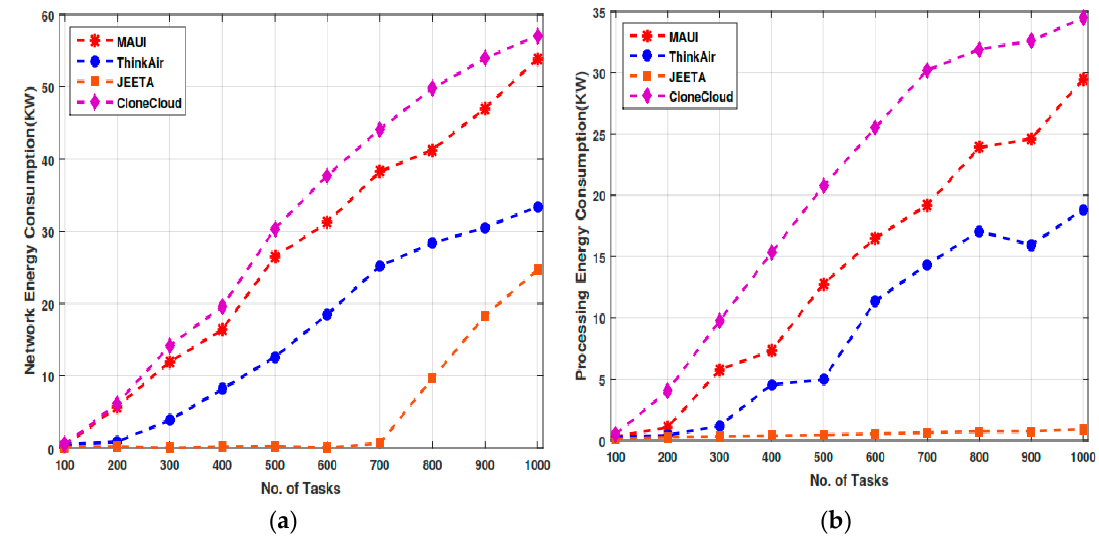
Figure 7. E nergy consumptions. ( a ) Network ; ( b ) Processing. Figure 7. Energy consumptions. ( a ) Network; ( b ) Processing.